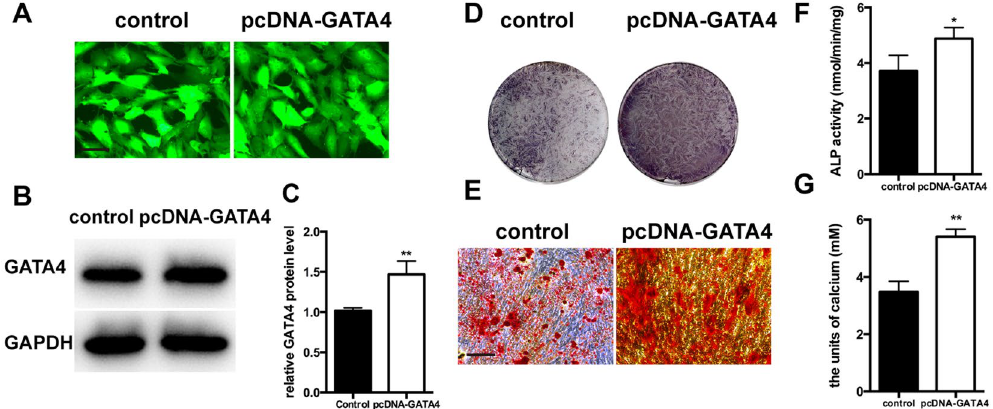
Figure 6. Overexpression of GATA4 in SCAPs increased the osteo/odontogenic ability. ( A ) SCAPs infected with lentivirus control and pcDNA-GATA4 were observed under fluorescence microscope (Bar: 50 μ m); ( B ) Protein expression of GATA4 in the SCAPs was tested by Western blotting; ( C ) After GATA4 overexpression in SCAPs, the efficiency of GATA4 knock-down post-lentiviral infection was assessed by Western blotting; ( D ) ALP staining was observed after 5 days mineralization; ( E ) ARS staining was performed 14 days after mineralization (Bar: 100 μ m); ( F ) Quantitative assessment of ALP activity after 5 days of osteogenic induction; ( G ) Semi-quantitative estimation of calcium. Data expressed as mean ± Standard Deviation; n = 3. * P < 0.05, ** P < 0.01.